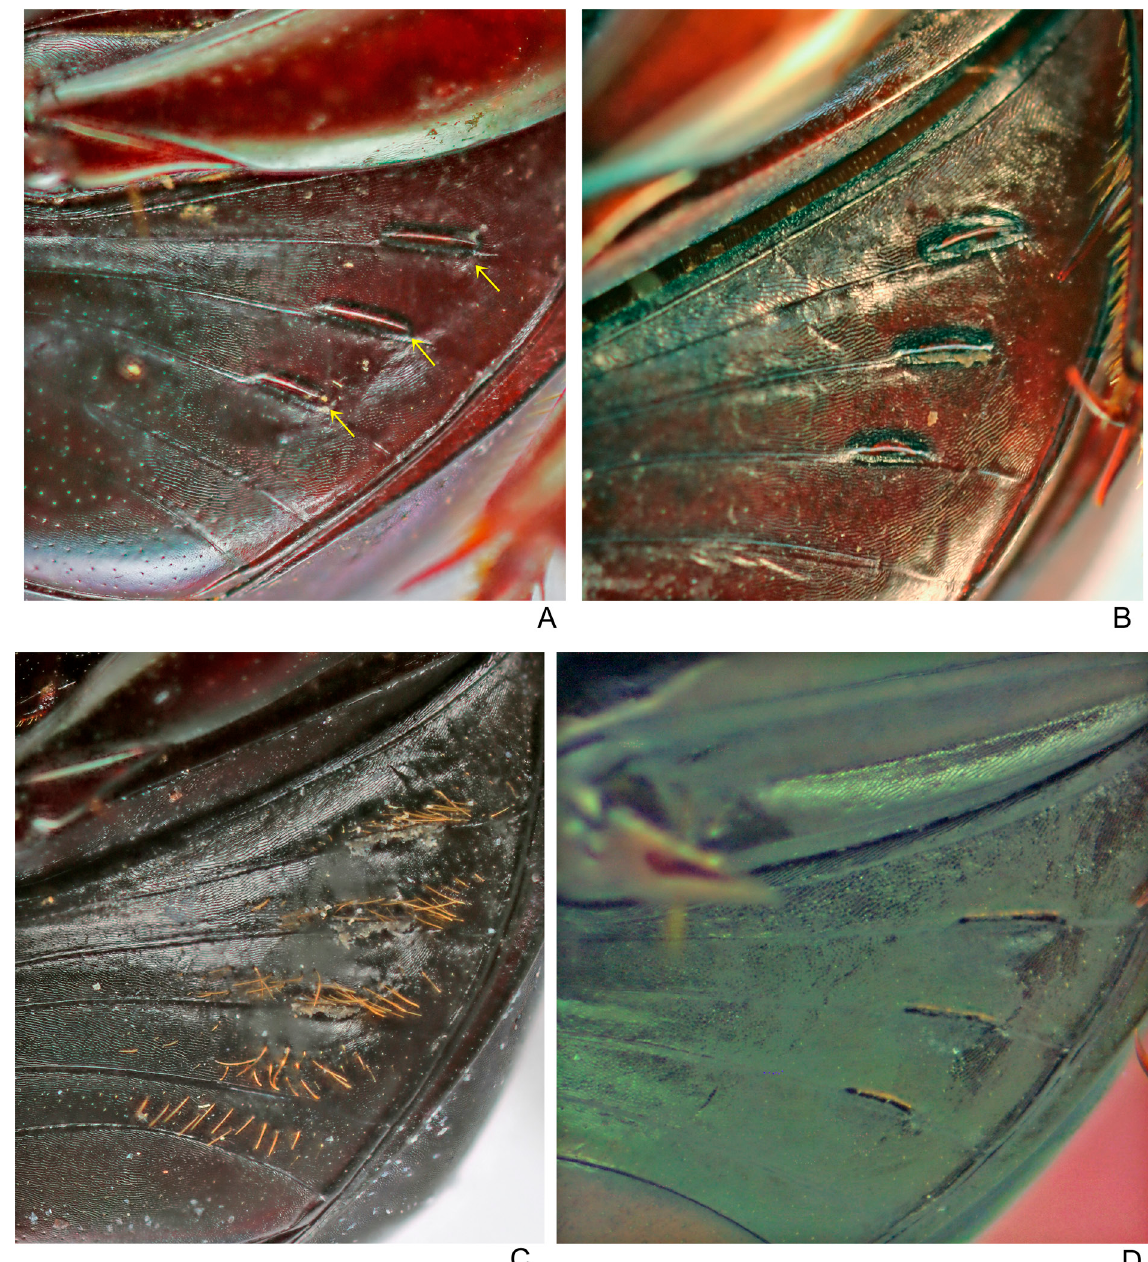
Fig. 16. Abdominal lateral foveae of females (arrows). A . Sylvicanthon furvus (Schmidt, 1920) . B . S. mayri sp. nov. C . S. obscurus (Schmidt, 1920) . D . S. foveiventris (Schmidt, 1920)